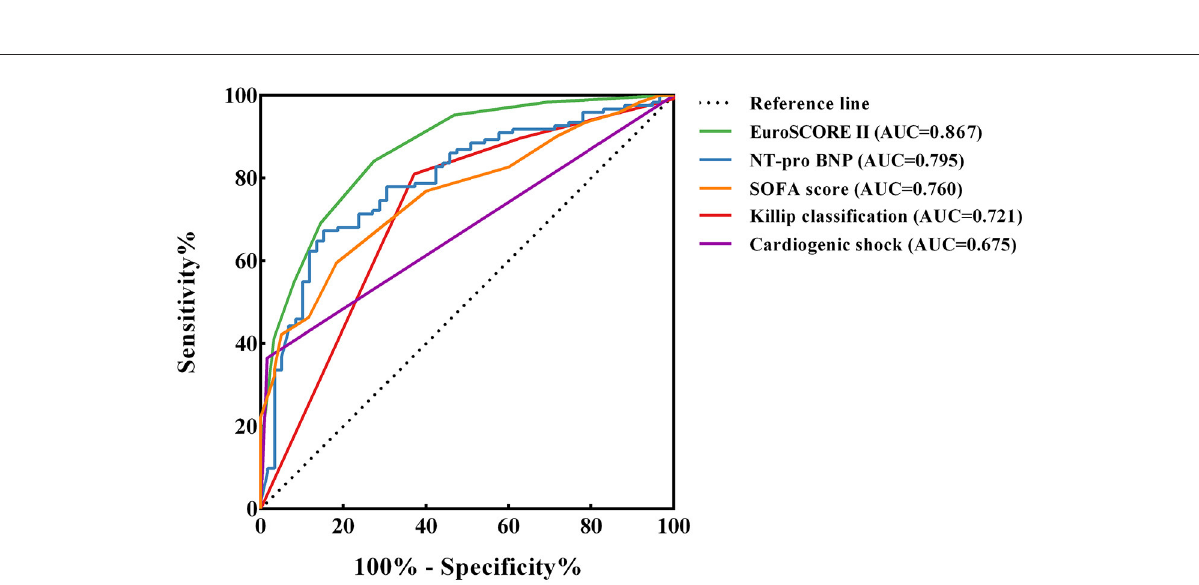
FIGURE3 ROC curves of EuroSCORE II, NT-pro BNP, SOFA score, Killip classification and Cardiogenic shock. ROC, receiver operating characteristic; AUC, area under curve ROC; CI, confidence interval; NT-pro BNP, n-terminal pro b-type natriuretic peptide; SOFA, sequential organ failure assessment. The following are the details of the five ROC curves: EuroSCORE II: Cut-off value = 14; AUC = 0.867 (95%CI: 0.813–0.921, P < 0.001); Sensitivity: 84.1%; Specificity: 72.6% NT-pro BNP: Cut-off value = 8,091; AUC = 0.795 (95%CI: 0.726–0.863, P < 0.001); Sensitivity: 67.2%; Specificity: 84.7% SOFA score: Cut-off value = 13; AUC = 0.760 (95%CI: 0.690–0.829, P < 0.001); Sensitivity: 59.5%; Specificity: 81.7% Killip classification: AUC = 0.721 (95%CI: 0.639–0.802, P < 0.001); Sensitivity: 81.0%; Specificity: 62.9% Cardiogenic shock: AUC = 0.675 (95%CI: 0.599–0.750, P < 0.001); Sensitivity: 36.5%; Specificity: